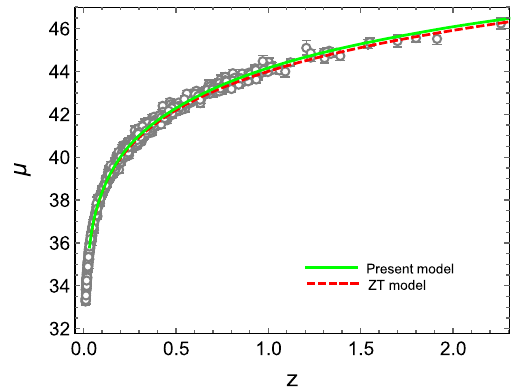
Fig. 8 Dependence of the distance modulus μ with redshift z . The open circles with error bars are supernova data points taken from [39]. SN1a absolute magnitude M 0 = − 19 . 36. The dashed red curve is our previous thermodynamically consistent model [23]. The solid green curve is the present model with power correction term. All entropic force models have a good agreement, with R 2 = 0 . 999 ... , we plotted two of the models for simplicity. In both cases, H 0 = 67 . 4 (km/s)/Mpc